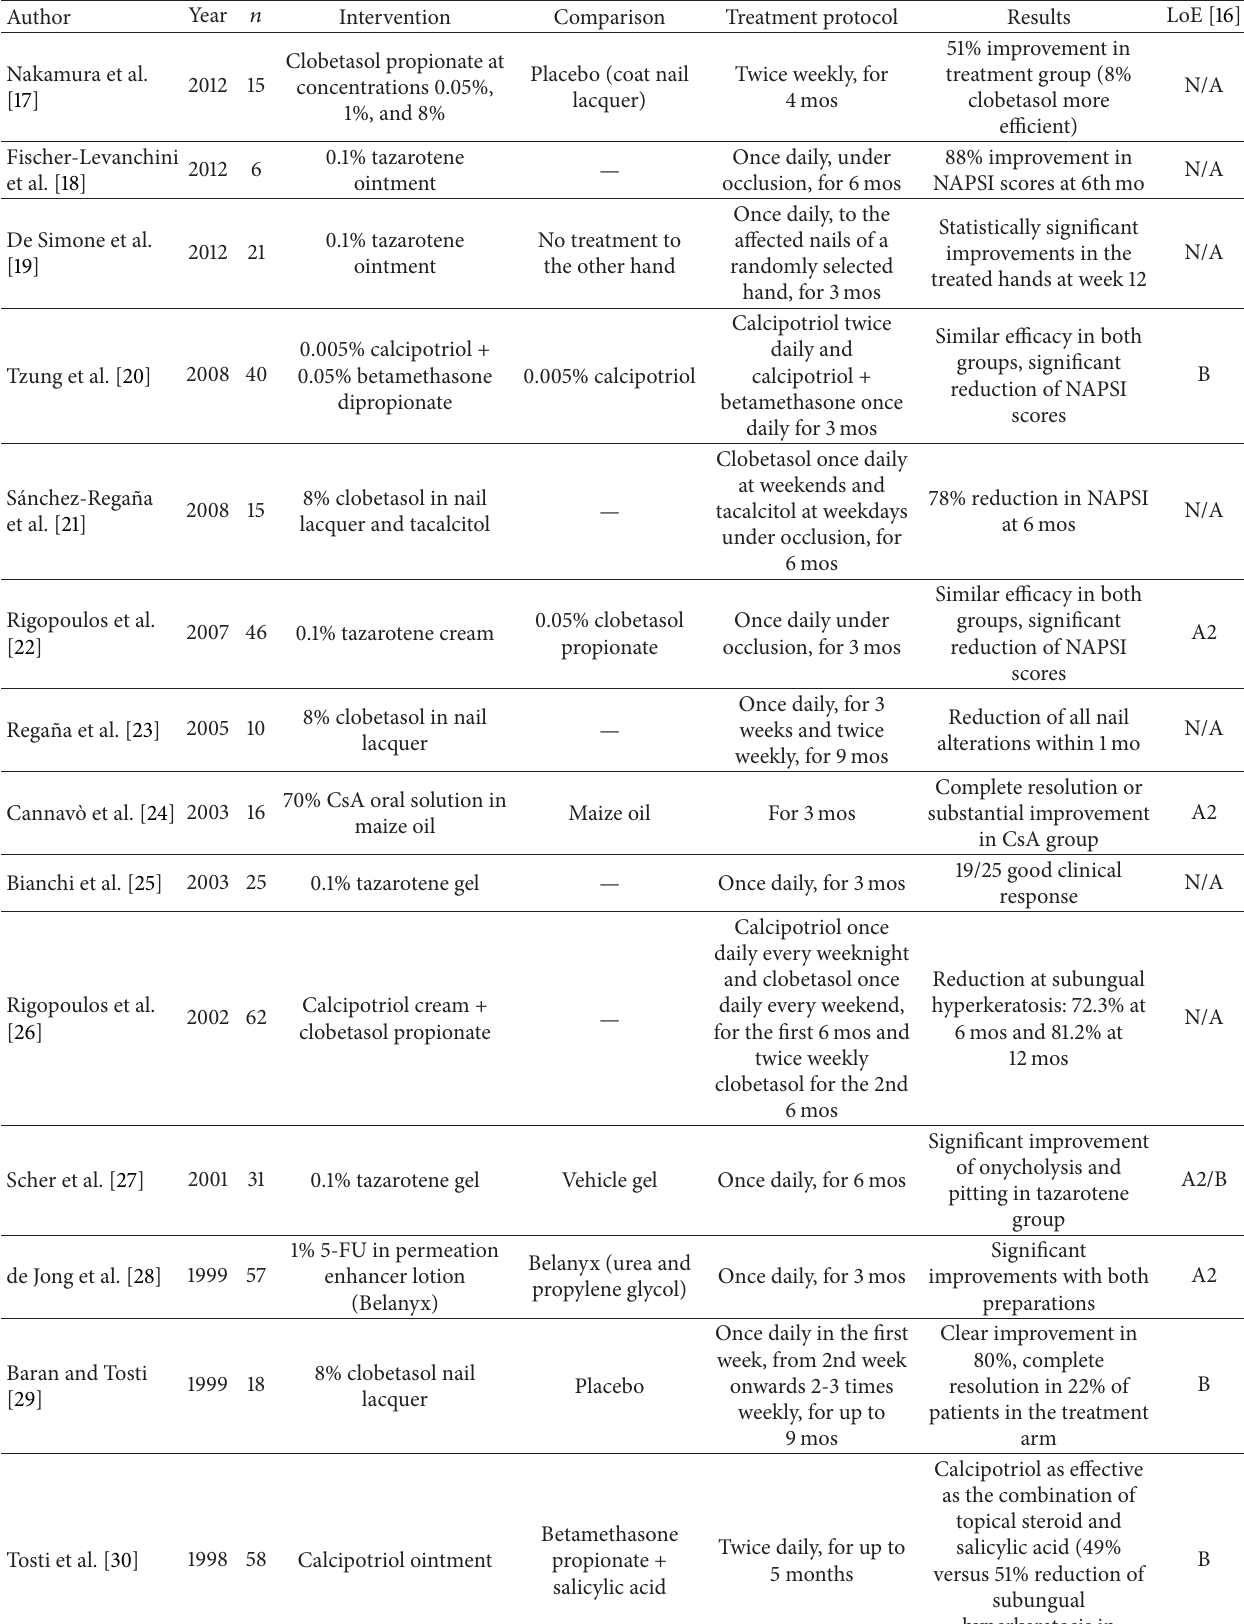
Table 1: Topical therapies for treatment of nail